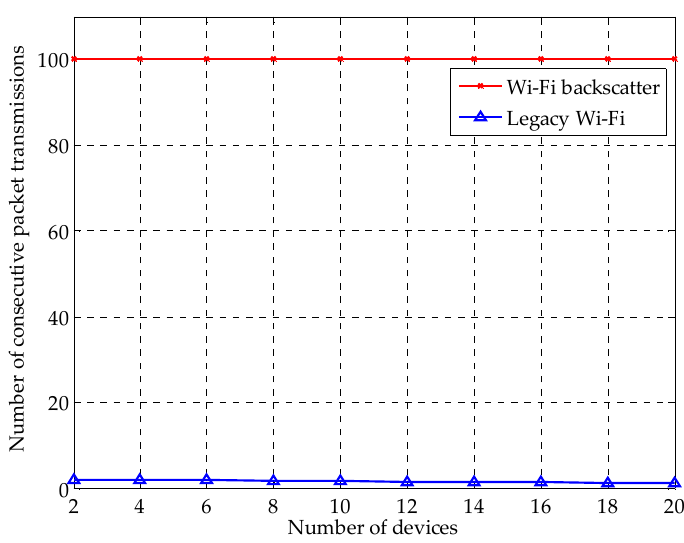
Figure 8. Variation of the number of consecutive packet transmissions.